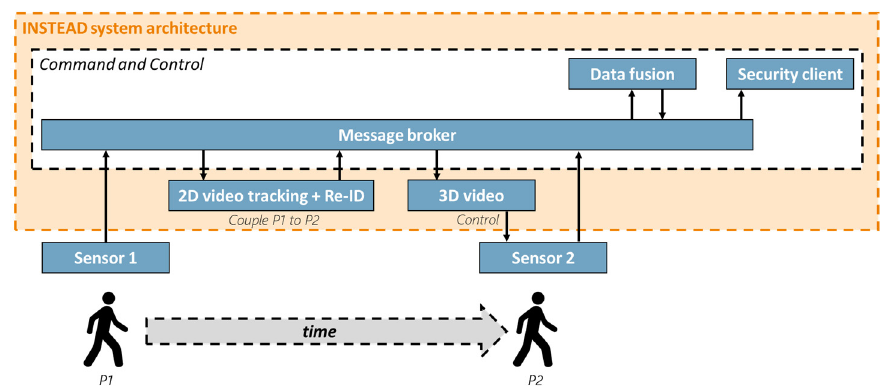
Figure 1. INSTEAD system architecture.